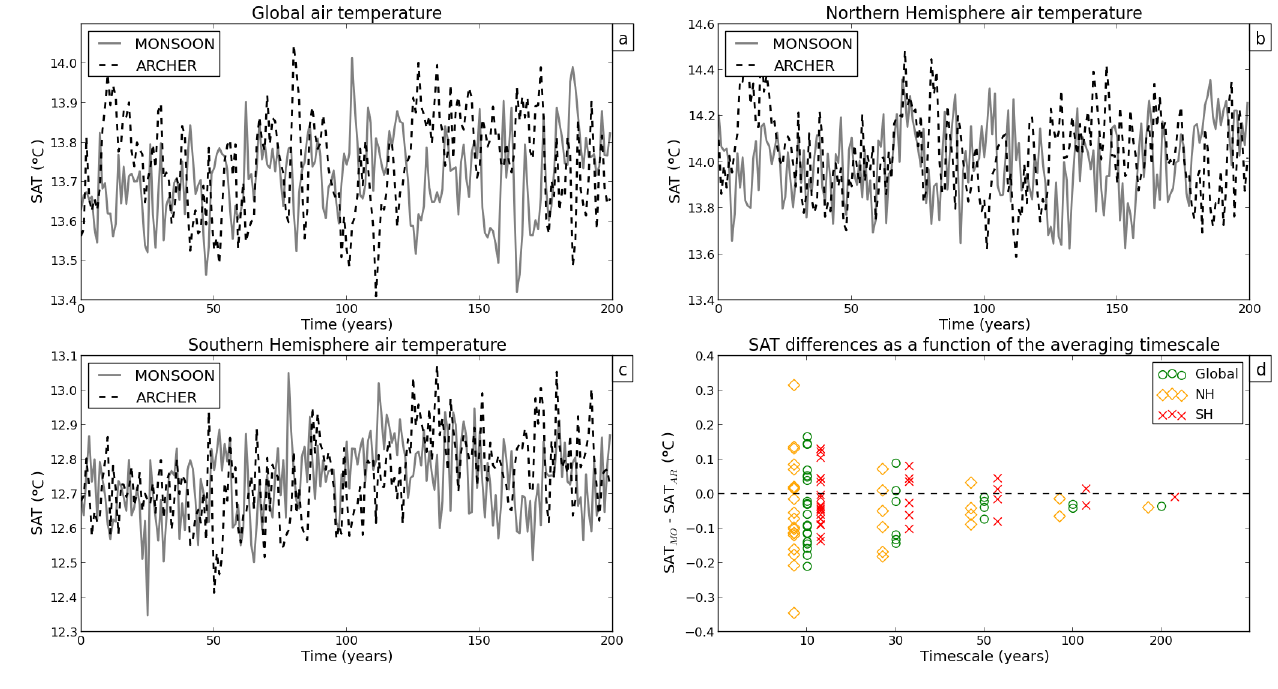
Figure 6. As in Fig. 4 but for SAT.